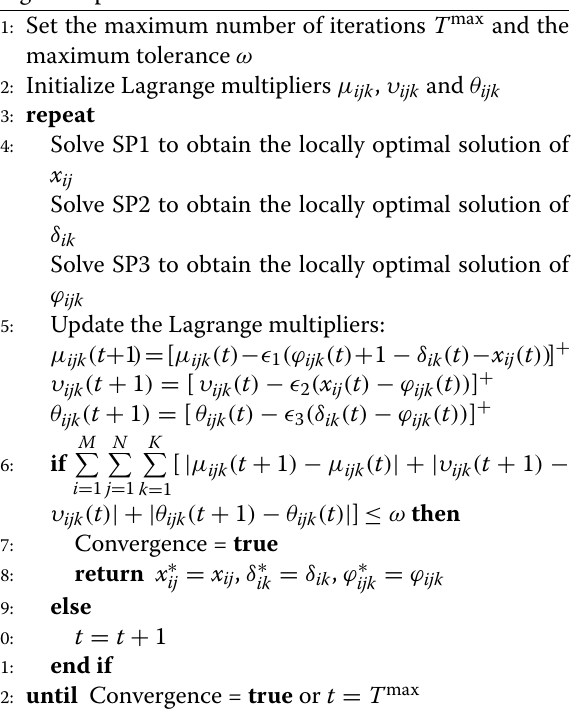
Algorithm 1 Proposed Iterative Algorithm for Solving the Original Optimization